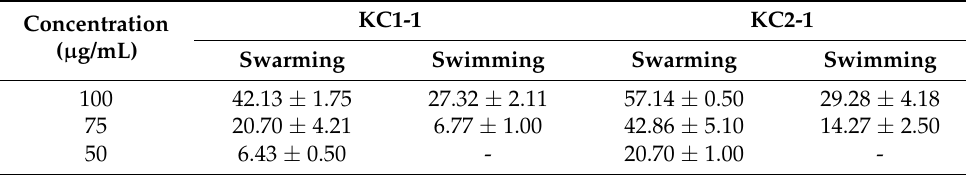
Table 5. Swarming and swimming motility inhibition of P. aeruginosa PA01 (%).